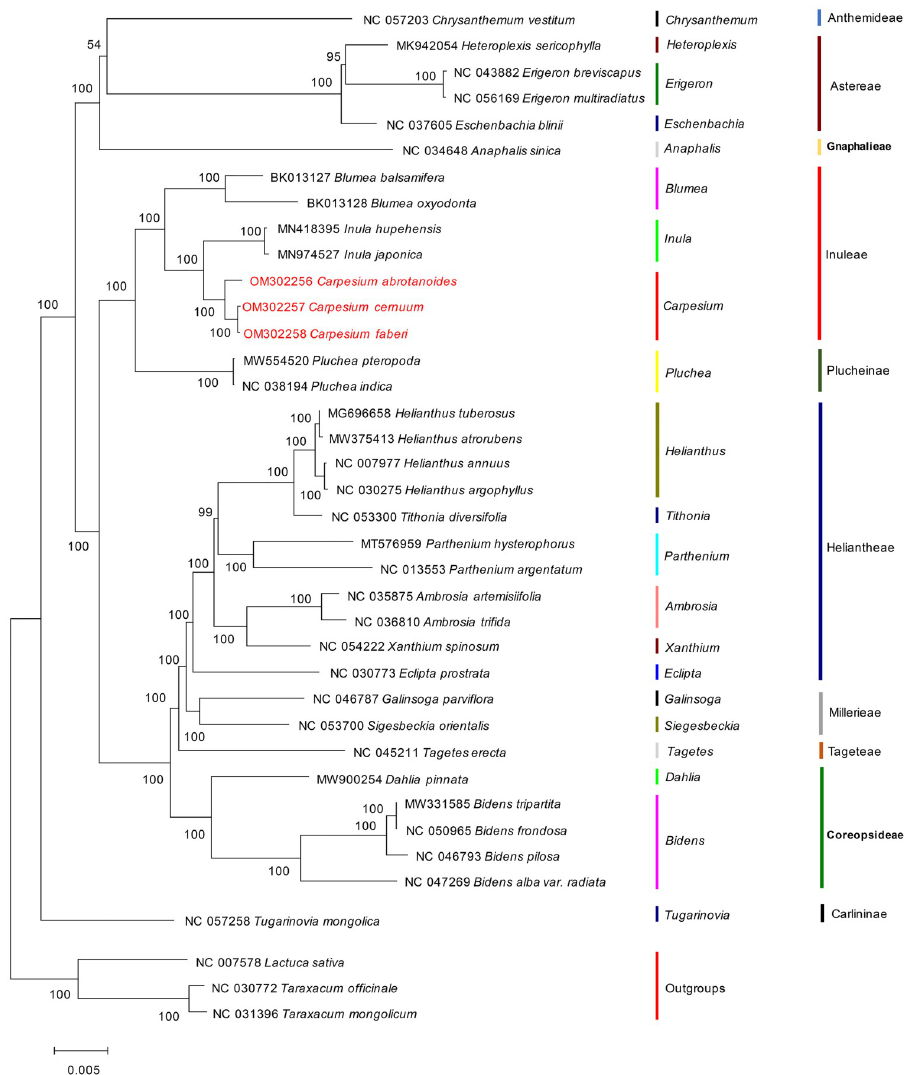
Fig 8. Maximum likelihood (ML) method phylogenetic tree constructed based on cp genome sequences of 38 species. The data next to each column represent bootstrap test scores. Taraxacum mongolicum , Taraxacum officinale , and Lactuca sativa were set as